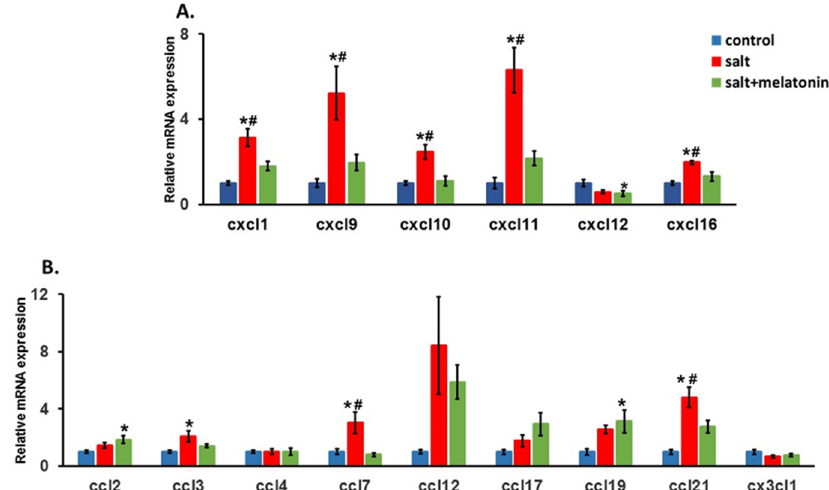
Figure 3. Upregulation of kidney’s chemokines in HSD with and without melatonin. The expression of chemokine (C-X-C motif) ligand (CXCL) family ( A ), chemokine (C-C motif) ligand family and CX3CL1 ( B ) were determined in the rats. ( n = 7–8) *- p ≤ 0.05 versus control. #- p ≤ 0.05 versus salt+melatonin. HSD—high-salt diet.